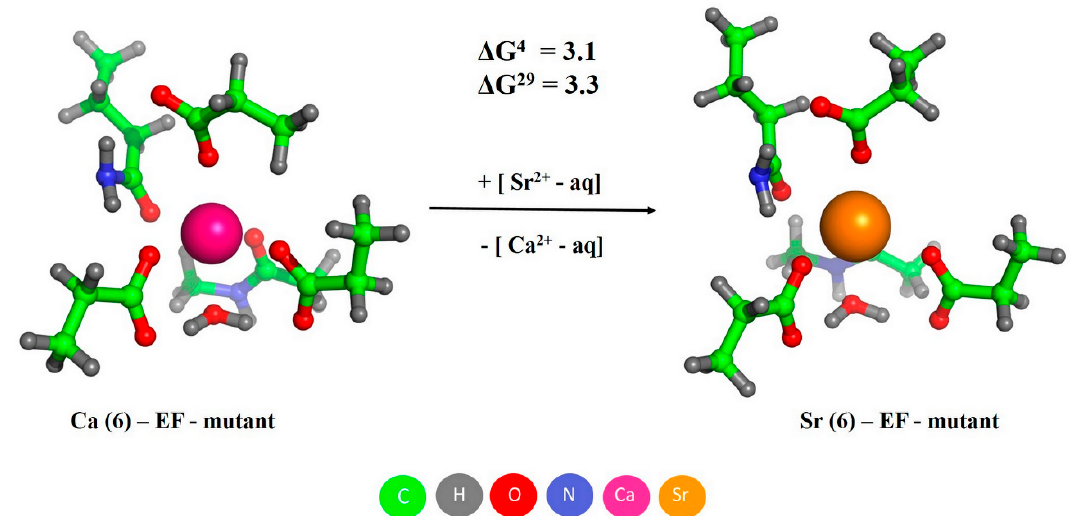
Figure 10. The optimized structures of Ca 2+ /Sr 2+ -loaded EF site of PA -EF , and free energies of metal exchange (in kcal/mol). Metal coordination number is indicated in parentheses in the complex name.